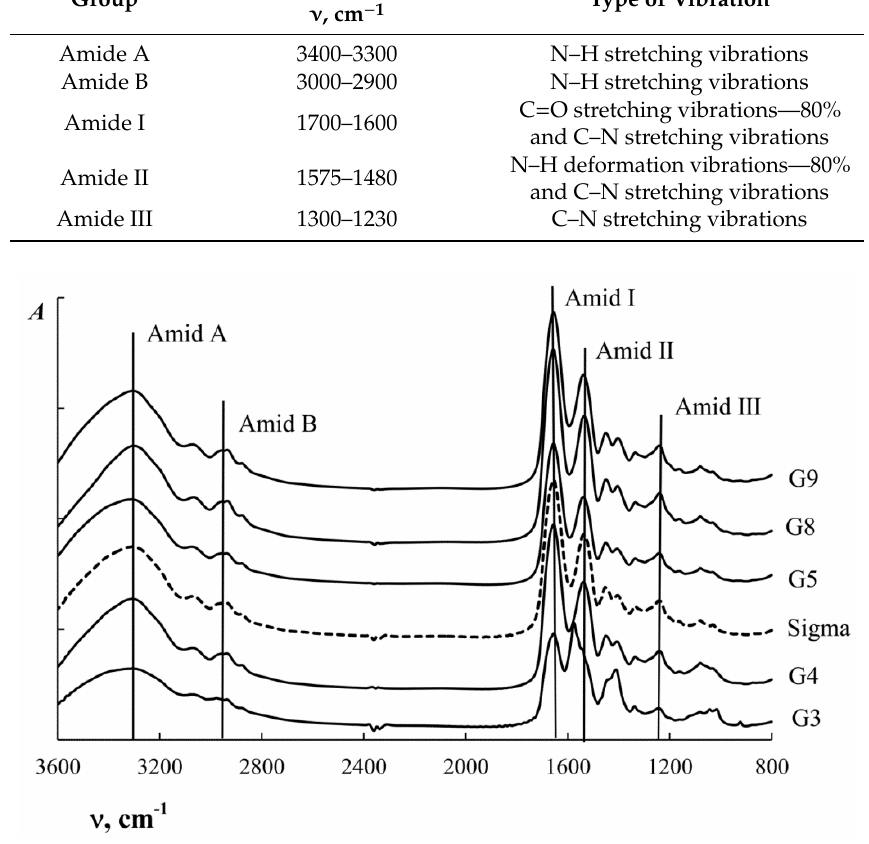
Figure 4. FTIR absorption spectra of cod gelatin samples obtained at different pH. pH values are given next to the appropriate spectra.